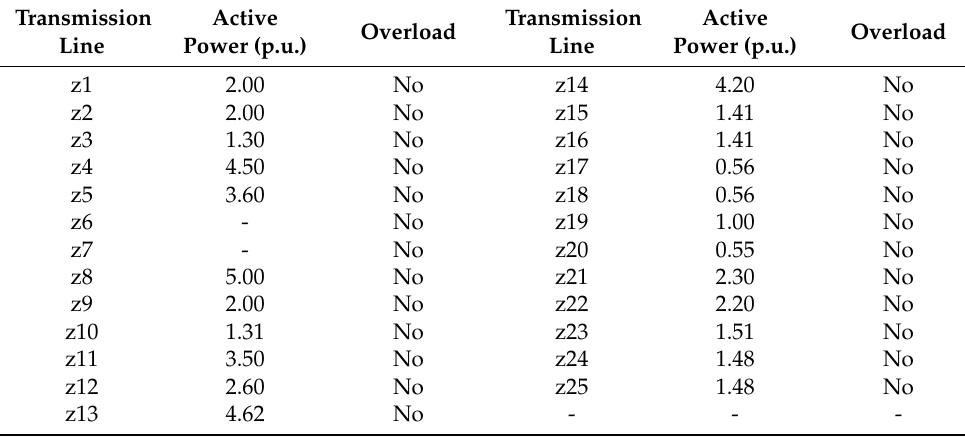
Table 9. Operation status of transmission lines in the regional power